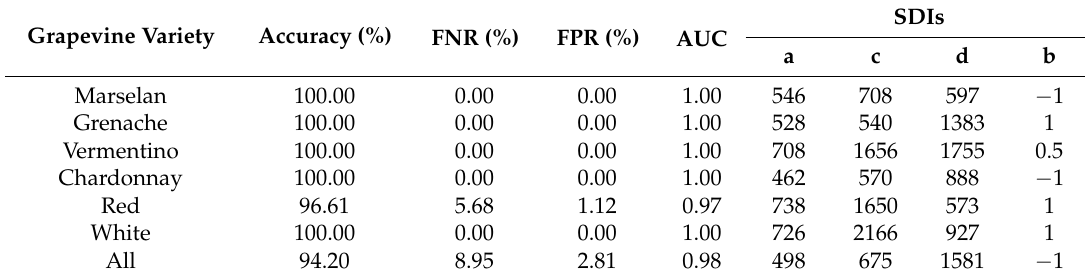
Table 10. Results of using SDIs in classifying different groups of spectral data acquired in the September acquisition campaign (Severity of infestation =